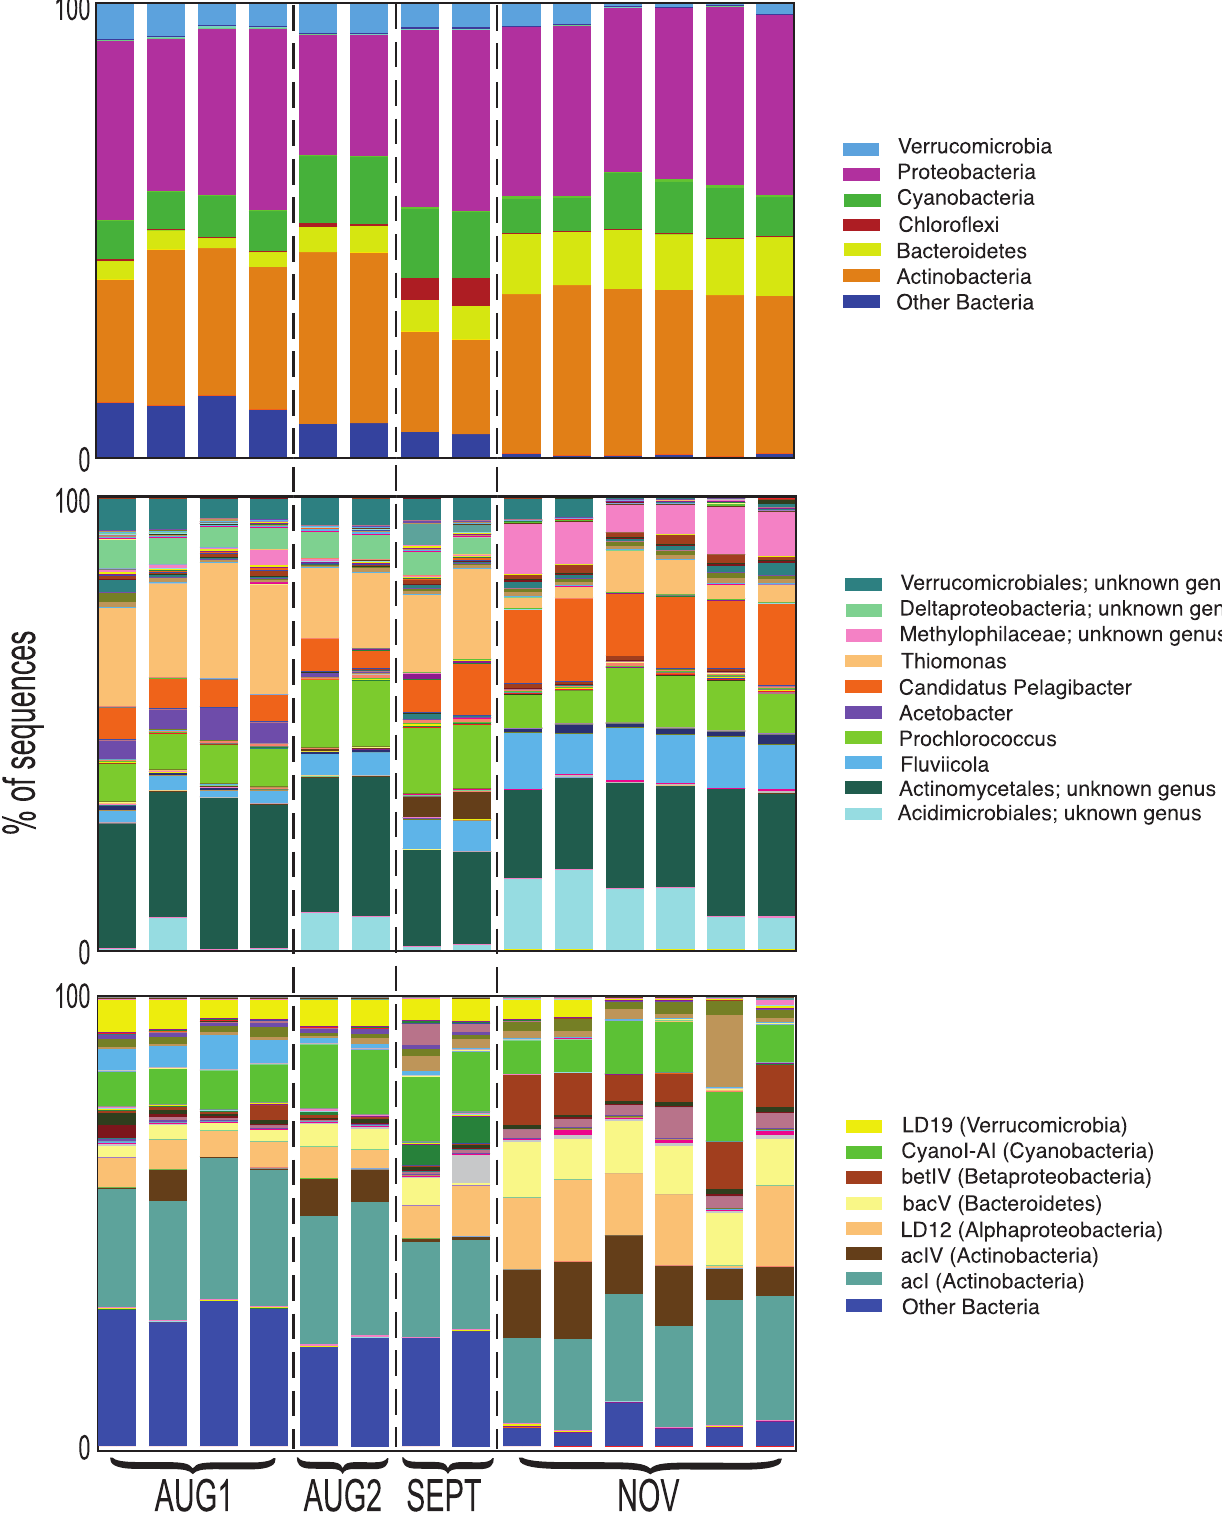
Figure 2. Community composition shifts over time as revealed by 16S data. Taxonomic binning of 16S amplicon sequences for each of the 14 individual datasets at the phylum (top) and genus (middle) levels were based on the July 2011 version of the Greengenes database [31]. Freshwater lineages (bottom) were based on a freshwater database according to the taxonomy framework described in Newton et al., 2011. Datasets are ordered left to right by date, technical sequencing replicate (lane 1 and lane 2), and DNA replicate (A, B and C). Taxa identified as major drivers of the differences between timepoints (SIMPER analysis) are labeled (see figure key).